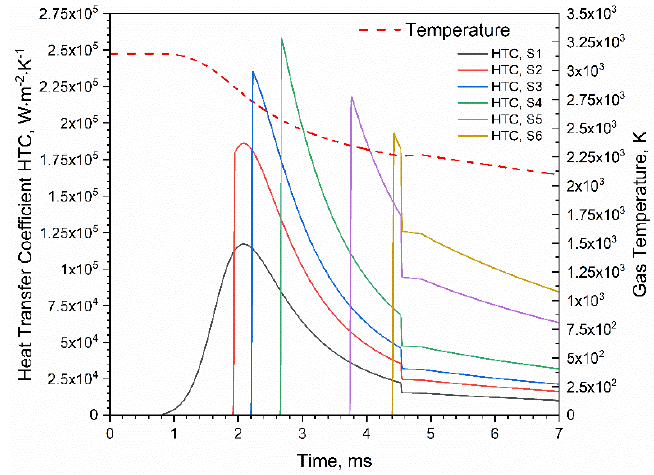
Figure 2. Heat transfer coefficient as a function of time h i ( t ) in the 6 cross-sections P1 to P6 and the gas temperature as a function of time T g ( t ) for the 35 mm anti-aircraft cannon barrel.